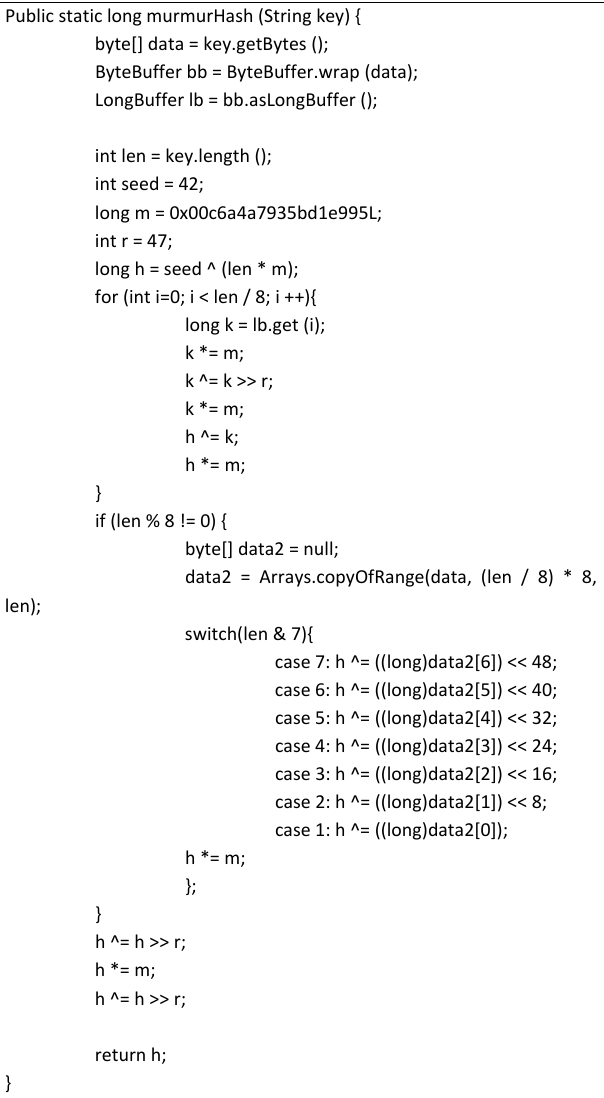
Fig. 1. Murmur hash in Java